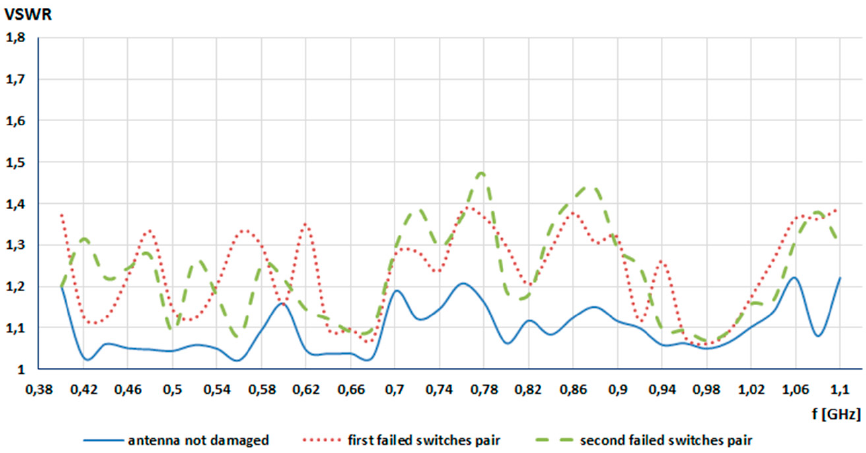
Figure 4. VSWR stability in the frequency range from 400 MHz to 1100 MHz.